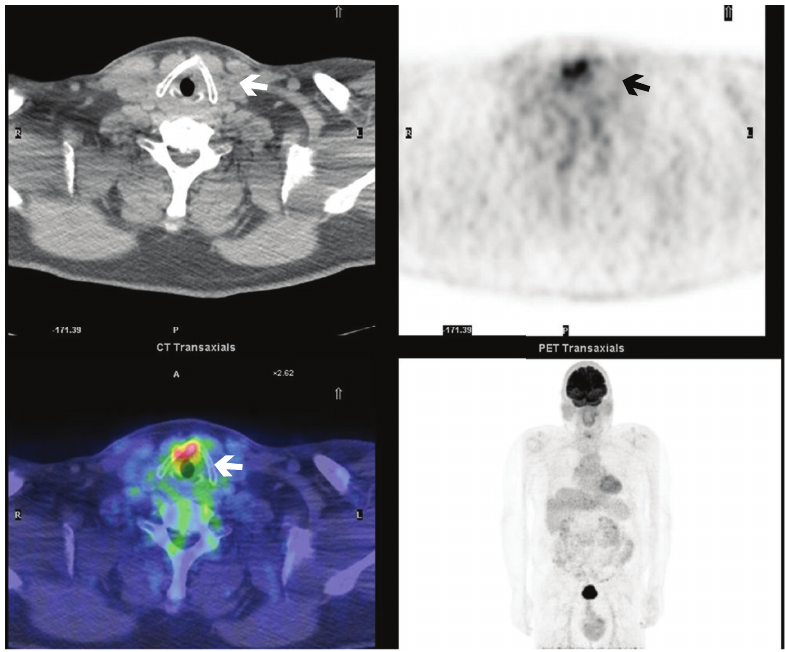
Figure 5: Asymmetrical 18 F-FDG uptake appreciable in larynx at PET/CT scan (arrow).